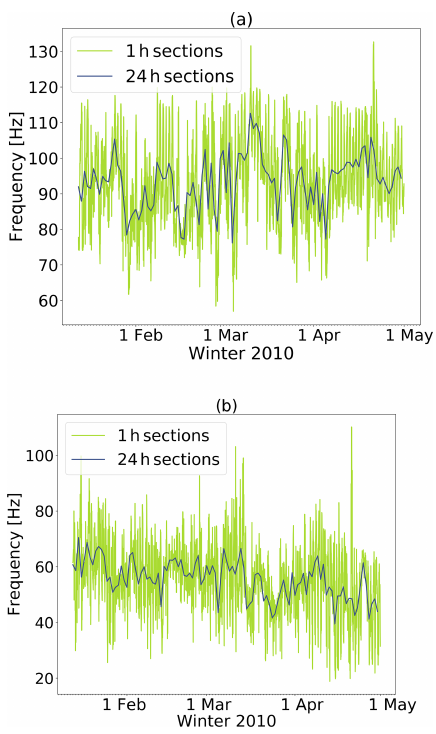
Figure 5. (a) Temporal variations in the central frequency hourly average (yellow) and daily average (blue). (b) Temporal variations in the dominant frequency.